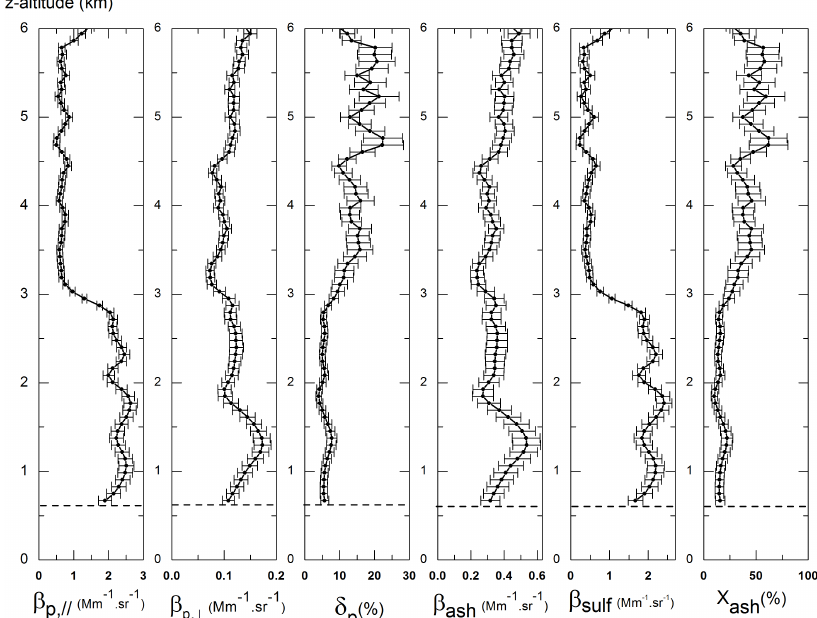
Fig. 7. Vertical profiles of backscattering coefficients β p ,// , β p , ⊥ , depolarization ratio δ p , retrieved β ash and β sulf coefficients and ash particle backscattering fraction X ash = β ash / β p in the mixed { ash, sulfate } particle cloud on 19 April 2010 at 19:00UTC at Lyon. The experiment is performed in the UV ( λ